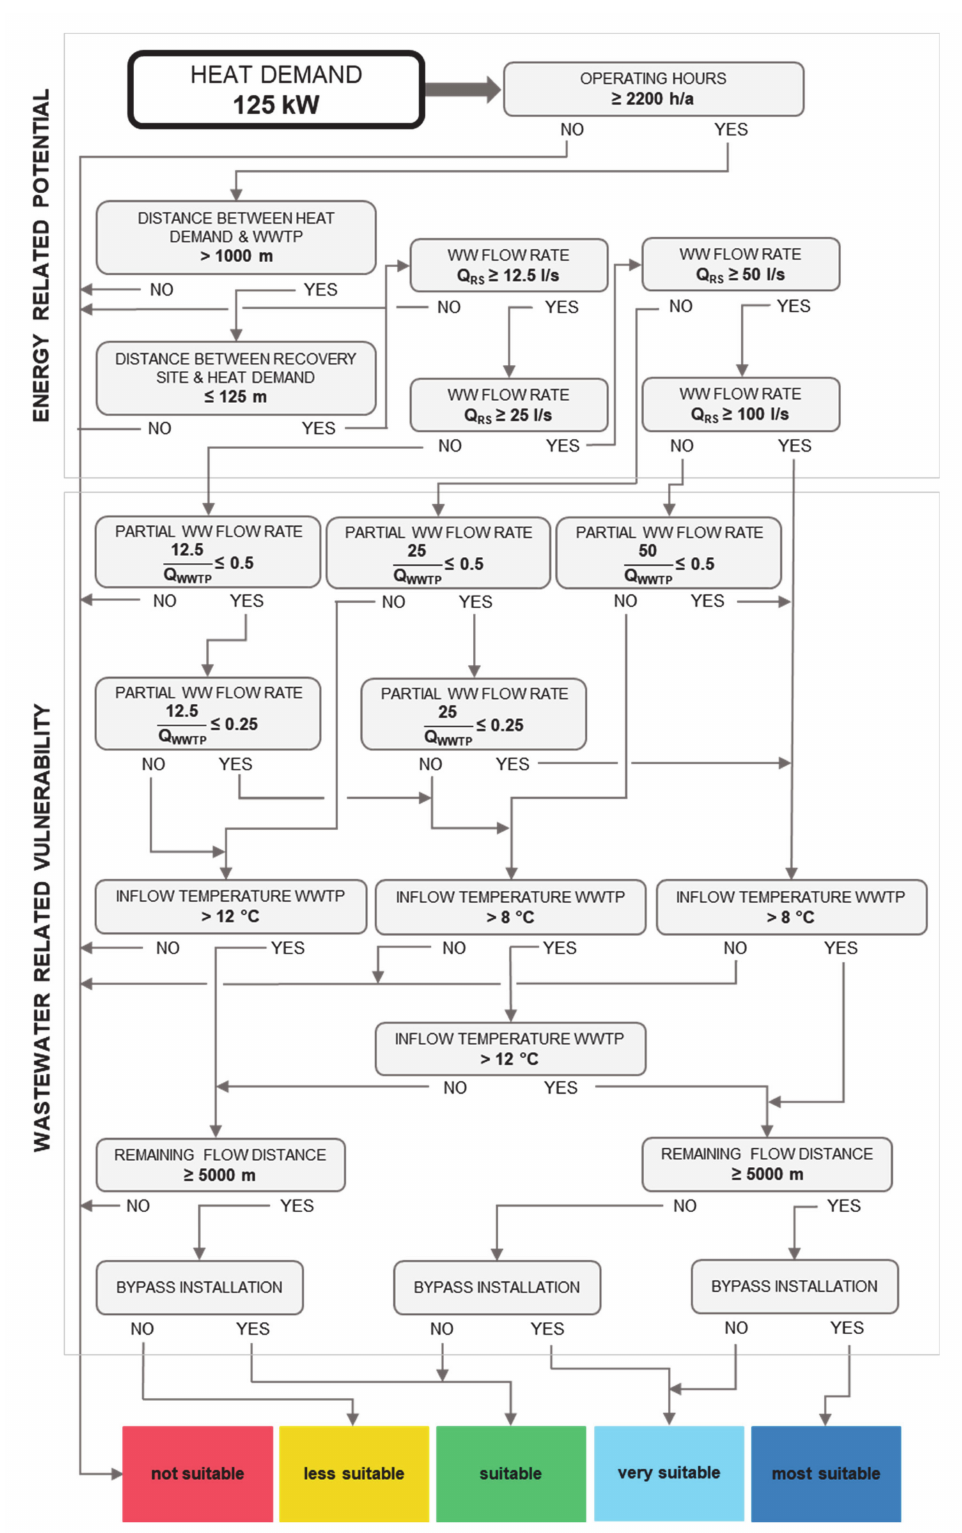
Figure A2. Relevance tree for an intended heat supply of 125 kW (own representation, based on